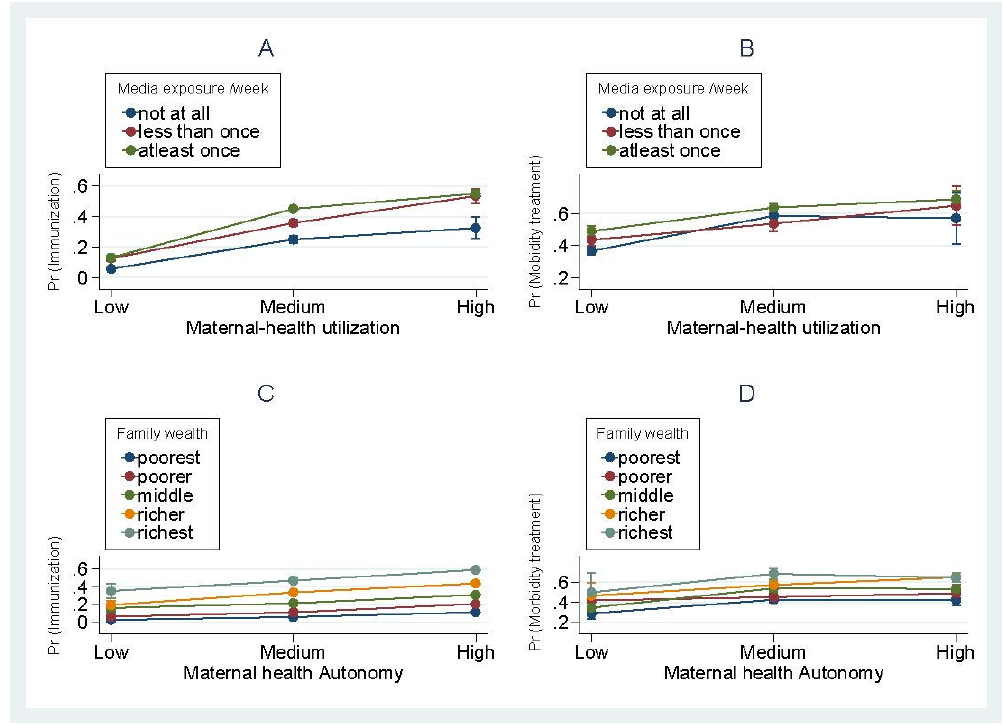
Figure 1. The relationship between maternal-health utilization and child healthcare as moderated by mothers’ exposure to media and the relationship between health autonomy and child healthcare as moderated by family wealth.